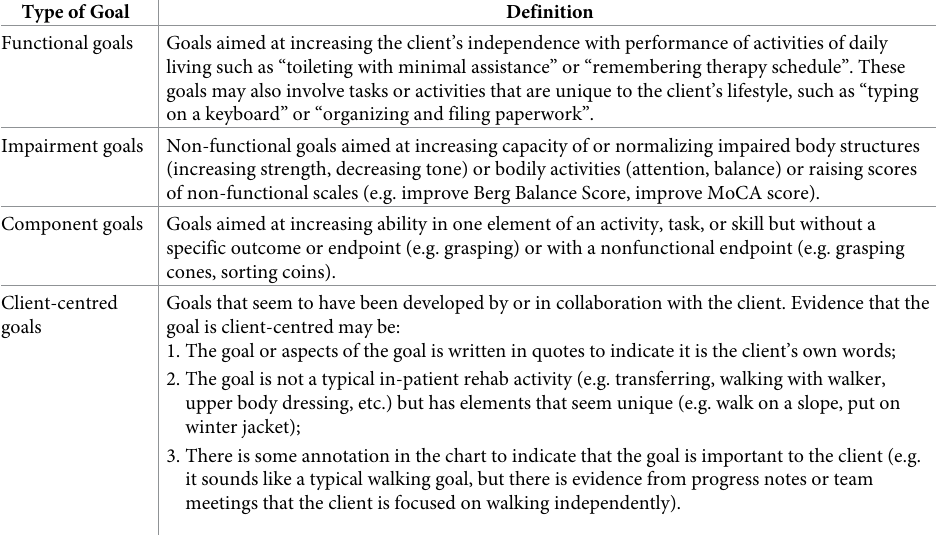
Table 2. Working definitions for goal